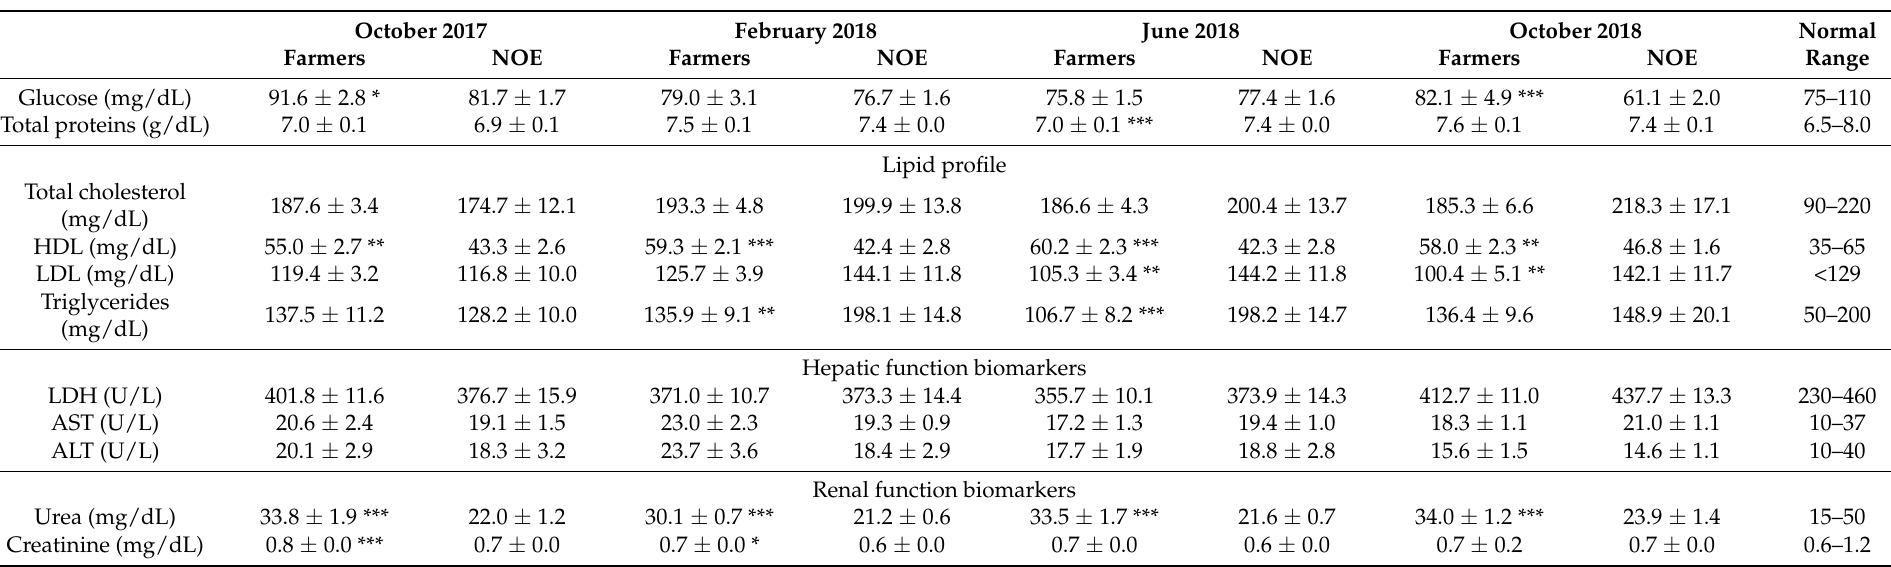
Table 3. Effects on biochemical and on liver and renal profile in farmers and in non-occupational exposed (NOE) groups. Data are expressed as the mean ± SEM. * p < 0.05; ** p < 0.01; *** p < 0.001 versus NOE group. ALT: alanine transaminase; AST: aspartate aminotransferase; HDL: high-density lipoprotein; LDH: lactate dehydrogenase; LDL: low-density lipoprotein.